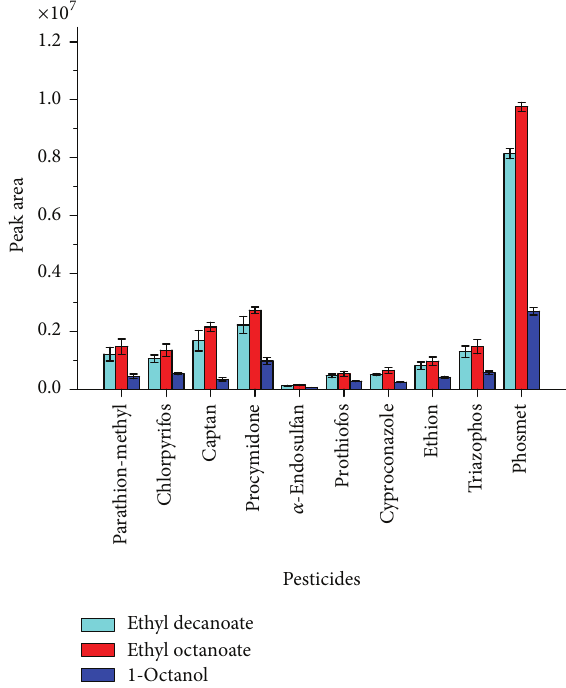
Figure 1: Effect of organic solvent on pesticide’s extraction effi- ciency. Conditions of the donor phase: 15 mL of water spiked at 100 𝜇 gL −1 of each pesticide; extraction time of 60 min; and stirring speed of 100rpm. Error bars represented the standard deviation of the mean peak area for 𝑛 = 3